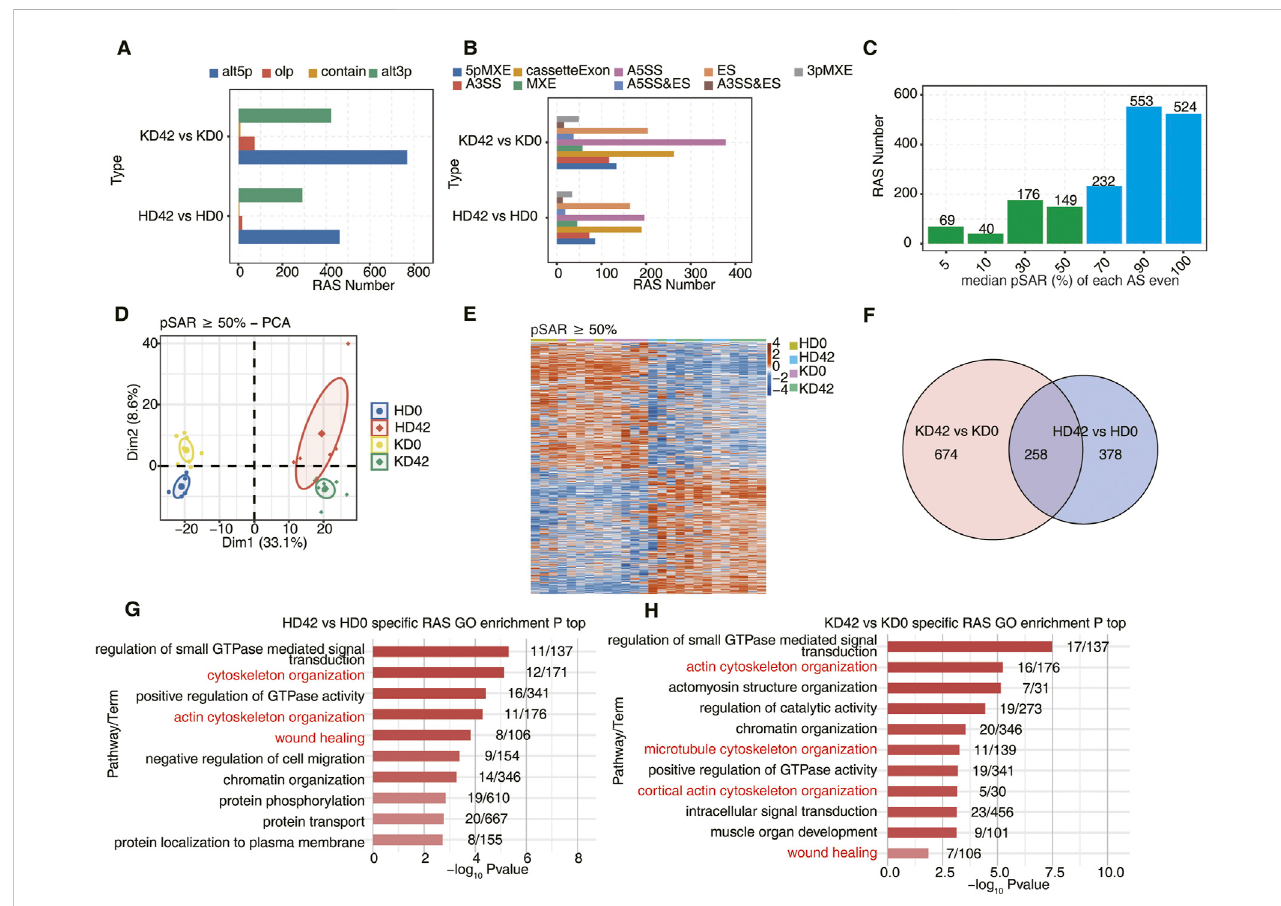
FIGURE 2 Analysis of alternative splicing during local skin repair in KPI and HC after 42 days of a wound. (A) Barplot showing the number of regulatory AS detected by SUVA in each group. ‘ alt3p ’ indicates the model that 5 ʹ splice site is shared and 3 ʹ splice site is alternative. “ alt5p ” indicates the model that 3 ʹ splice site is shared and 5 ʹ splice site is alternative. “ olp ” indicates a model that both splice sites are different but part of the splice junction are overlapped. “ Contain ” indicates a model that both splice sites are different but one splice junction is contained in another splice junction. (B) Splice junction constituting RAS events detected by SUVA was annotated to classical AS event types. And the number of each classical AS event type was shown with a barplot. (C) Barplot showing RASwith differentpSAR. RAS which pSAR (Readsproportion ofSUVA ASevent) ≥ 50% werelabeled. (D) Principal componentanalysis (PCA) based on RAS of pSAR ≥ 50%. The ellipse for each group is the con fi dence ellipse. (E) The Heatmap showing the splicing ratio of RAS (PSAR ≥ 50%). (F) Venn diagram showing overlap of RAS id between KPI (day42 and day0) and HC (day42 and day0) groups. (G) Bar plot showing the most enriched GO biological process resultsforspeci fi cRAS(pSAR ≥ 50%)intheHCgroup. (H) BarplotshowingthemostenrichedGObiologicalprocessresultsforspeci fi cRAS(pSAR ≥ 50%)inthe KPI